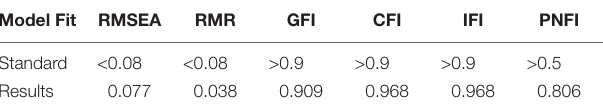
TABLE 4 | The Overall fitting situation of the